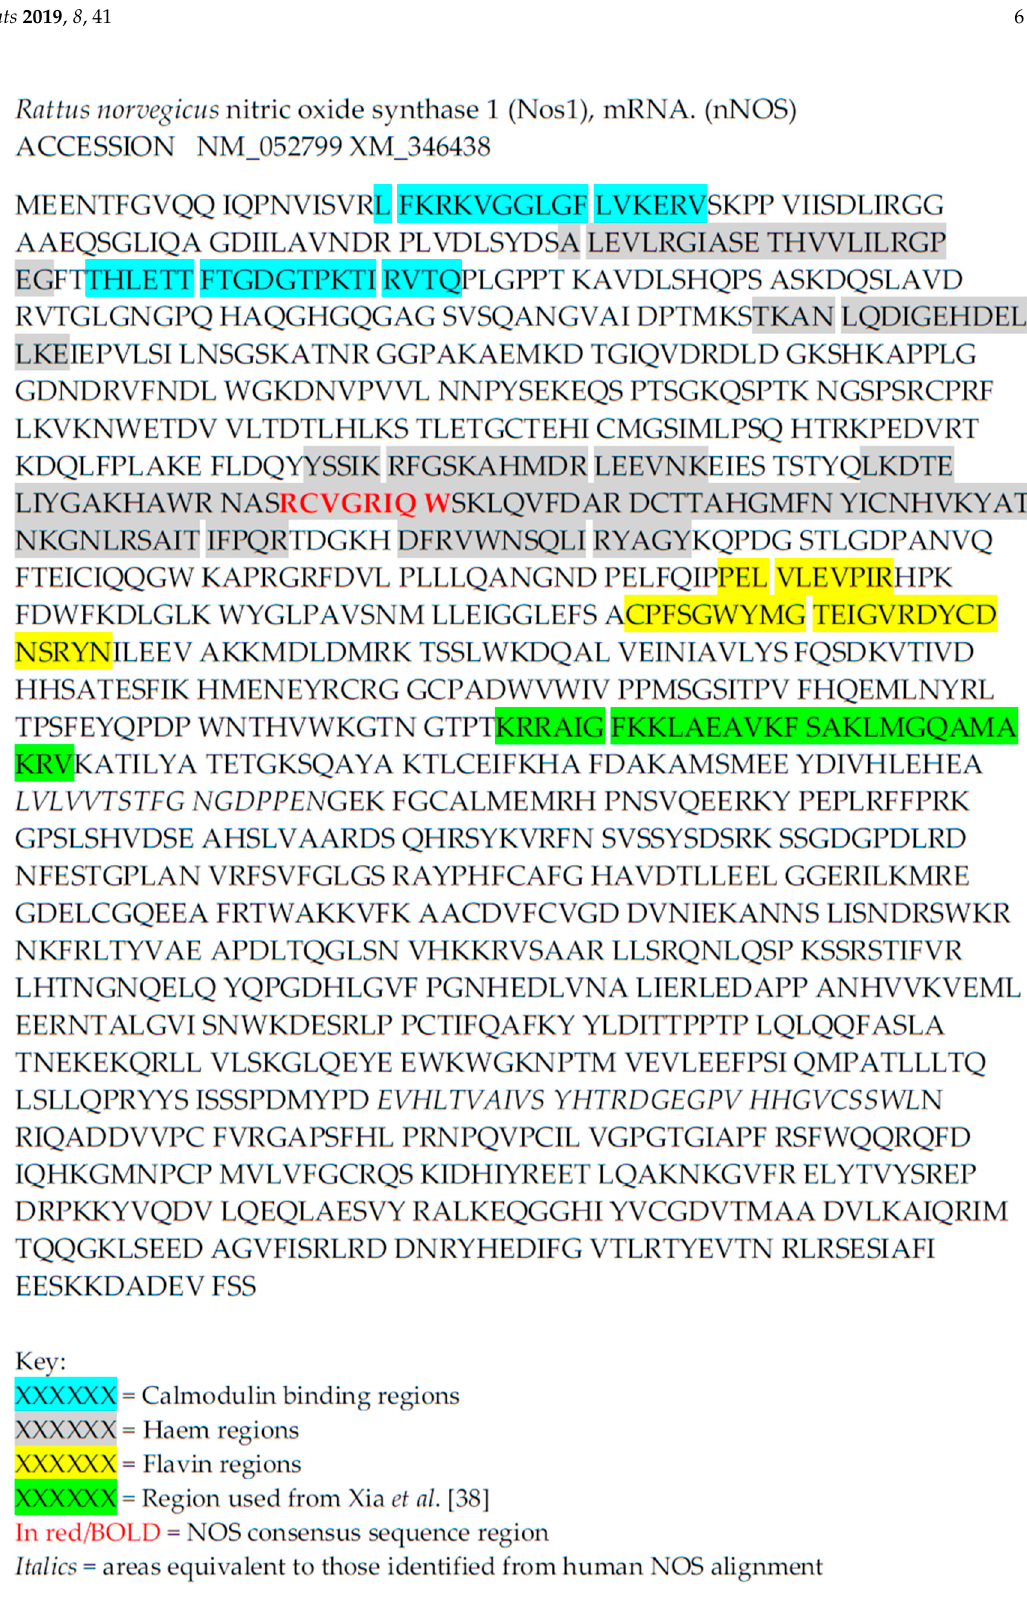
Figure 1. Areas of the rat NOS sequence used to search for higher plant NOS-like proteins. Findings shown in Table 1.